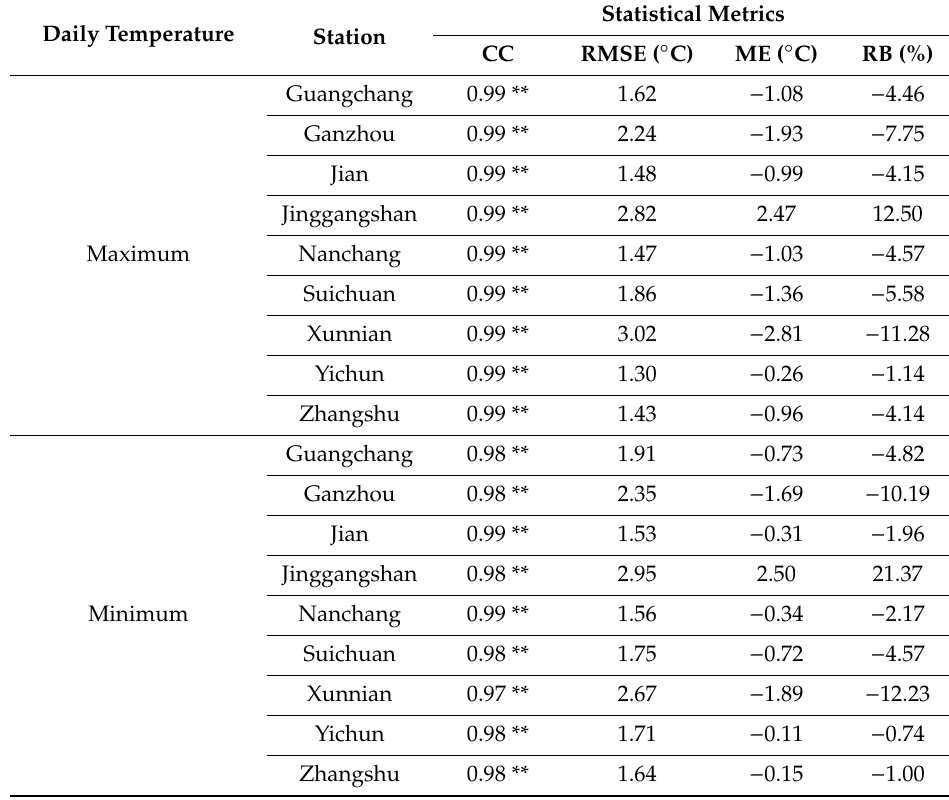
Table 4. Summary of statistical metrics for CMADS daily maximum and minimum temperature in the GRB. The metrics were calculated based on the grids with meteorological